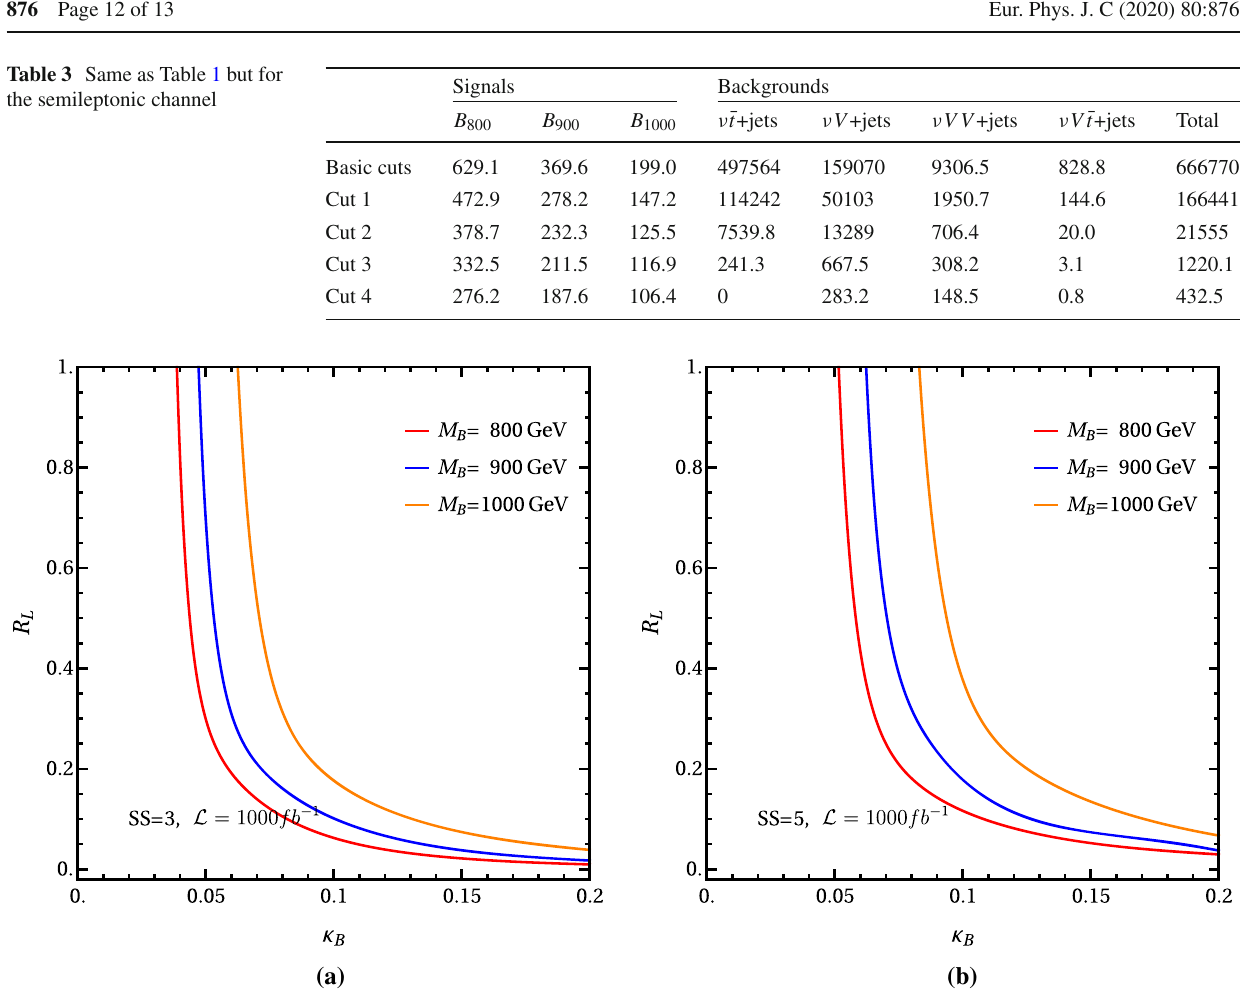
Fig. 10 Same as Fig. 5, but for the semileptonic channel